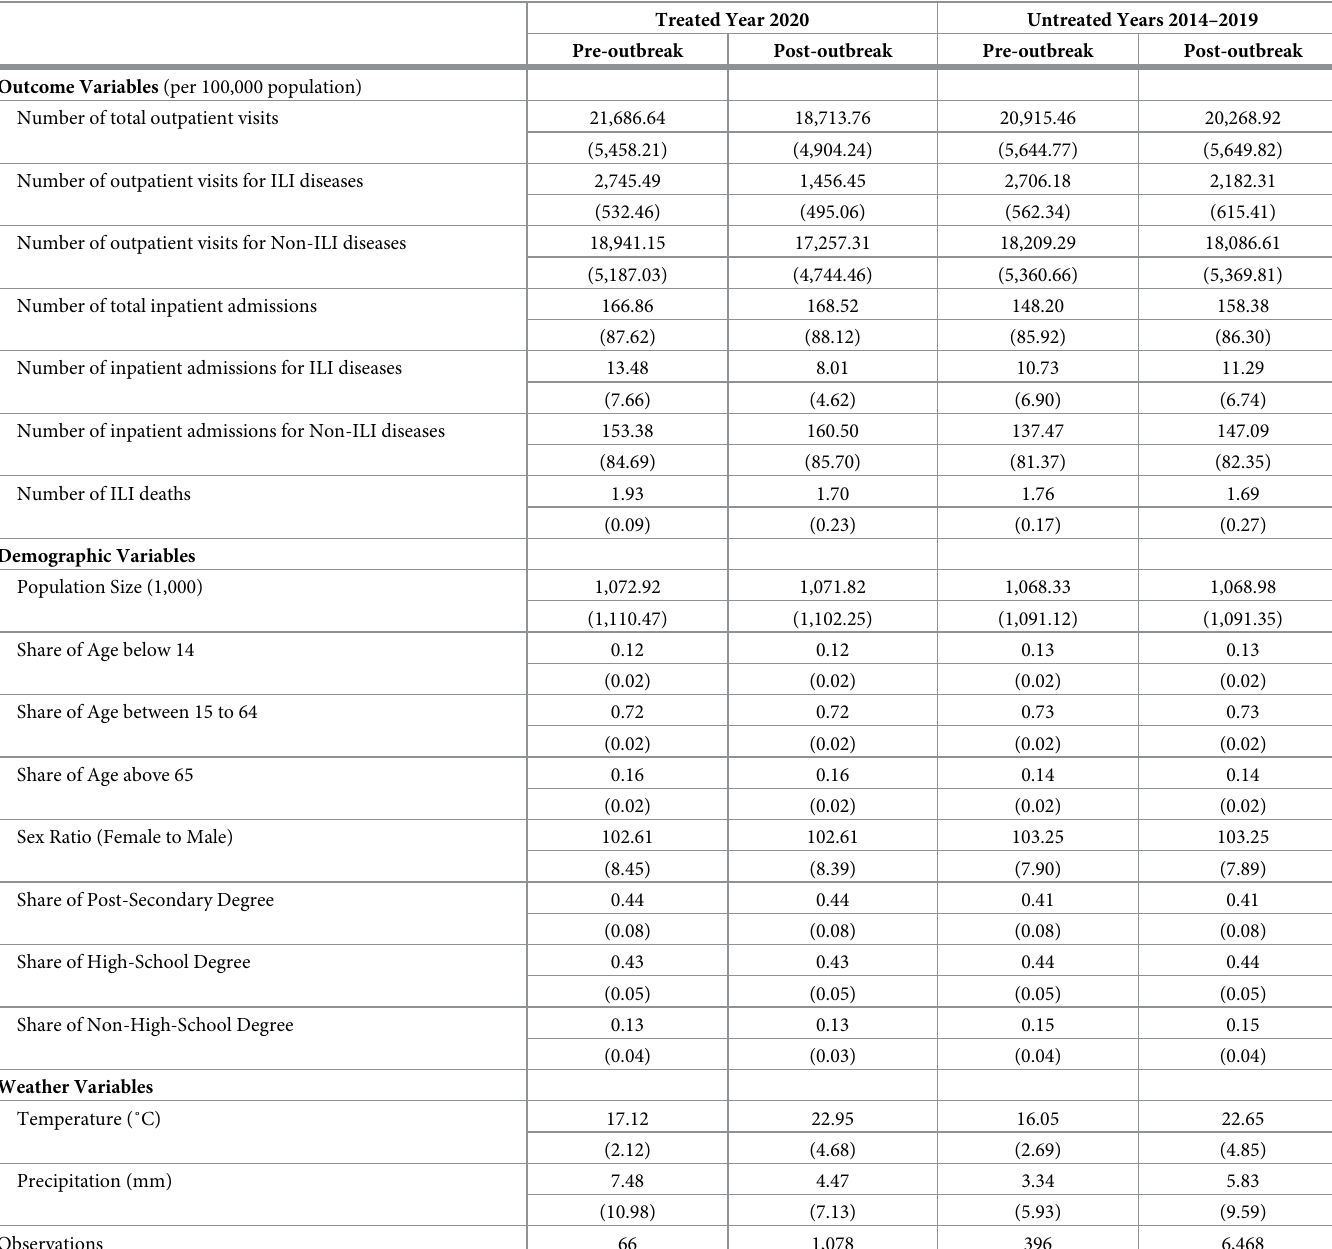
Table 1. Summary statistics for the treated and untreated